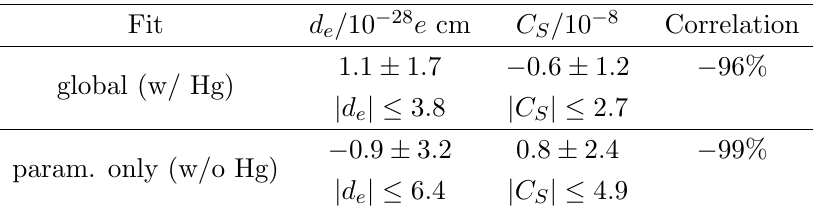
Figure 1 . Fit to the available data from paramagnetic systems plus the constraint from Mercury, using the result presented in this work. The bands from the individual constraints as well as the global (cid:12)t without Mercury correspond to 95% CL, the global (cid:12)t with Mercury to 68% and 95% CL. These bands include both experimental and theoretical uncertainties. Individual constraints have 1 e(cid:11)ective degree of freedom, the global (cid:12)ts 2.